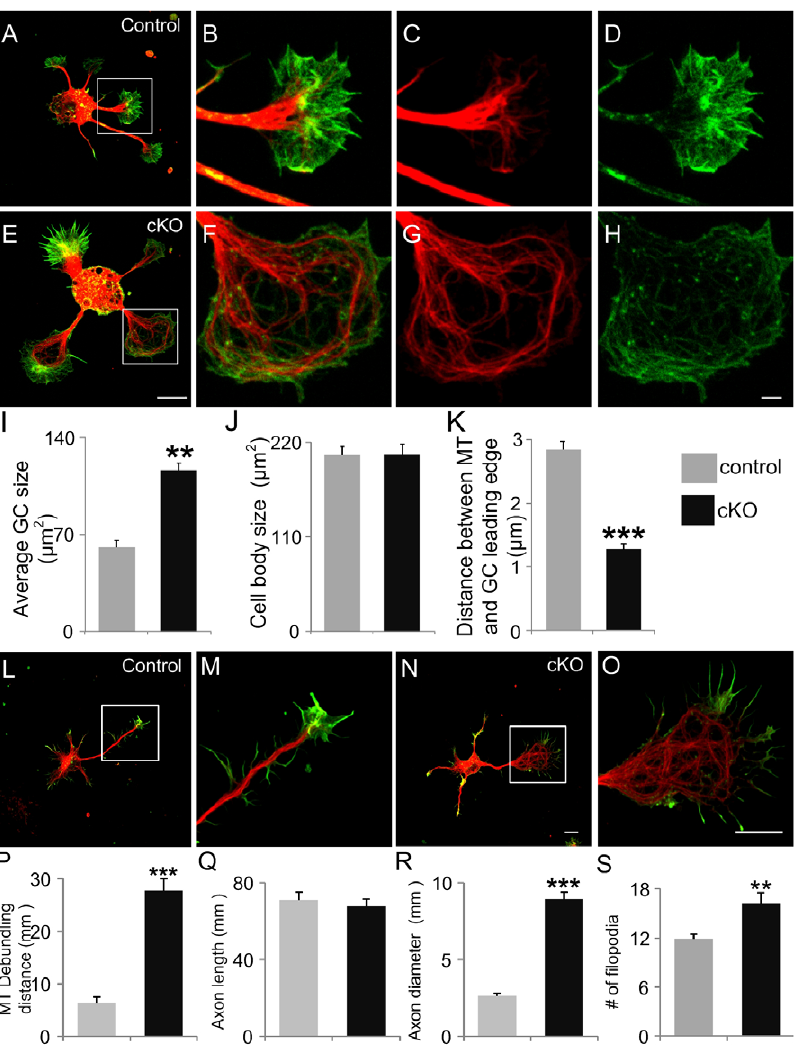
Figure 3. APC deletion induces cytoskeleton reorganization at axonal growth cones. (A and E) Control (A) and APC cKO (E) cortical neurons fixed at 1DIV and double stained with phalloidin (green) and anti- a -tubulin antibody (red). (B–D and F–H) Higher magnification images of control (B–D) and APC cKO (F–H) growth cones from the inserts shown in A and E. Note that microtubules gradually splay apart and extend towards the central domain of the growth cone in control neurons (C); in contrast, microtubules are highly debundled and disoriented in APC deficient growth cones. Disruption of F-actin allows microtubules to reach the growth cone leading edge (G). (I) Growth cone sizes of control and APC cKO neurons. (J) Cell body sizes of control and APC cKO neurons. (K) Distances between microtubule tips and the growth cone leading edge. Note microtubule tips frequently reach the leading edge in APC cKO growth cones. (L and N) Control (L) and APC cKO (M) cortical neurons fixed at 2DIV and double labeled with phalloidin (green) and anti- a -tubulin antibody (red). (M and O) High-magnification images of control and APC cKO growth cones from the inserts shown in L and N. (P) Distance of the debundled microtubules measured from the axon distal end to the point at axon shaft where microtubules are tightly bundled. Note that microtubules are debundled for a long distance at the distal part of APC cKO axons while microtubule debundling is restricted at the tip of control axons. (Q) Axon length. (R) Axon diameter at the thickest point. (S) Filopodia number at the growth cone of control and APC cKO neurons. n . 60 neurons for both control and APC cKO conditions. **: P , 0.005 and ***: P , 0.001 by two-tailed student t-test. Data are presented as mean 6 SEM. Scale bars: (A and E) 10 m m; (B–D and F–H) 2 m m; (L–O) 10 m m.